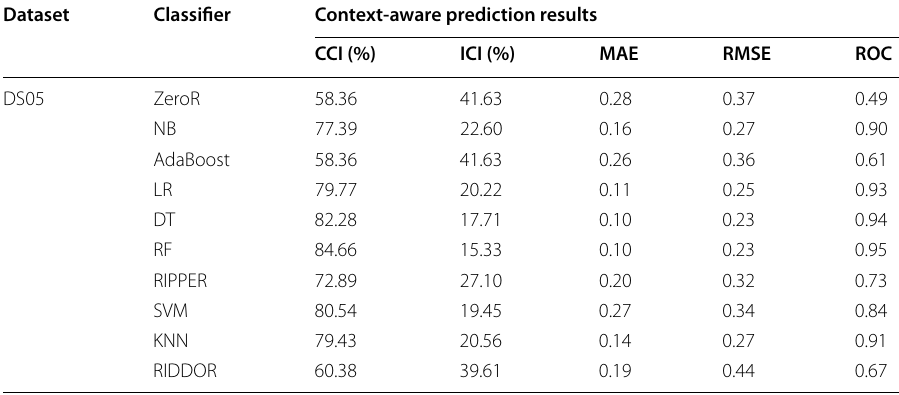
Table 3 Prediction results using various machine learning classification models utilizing dataset DS05